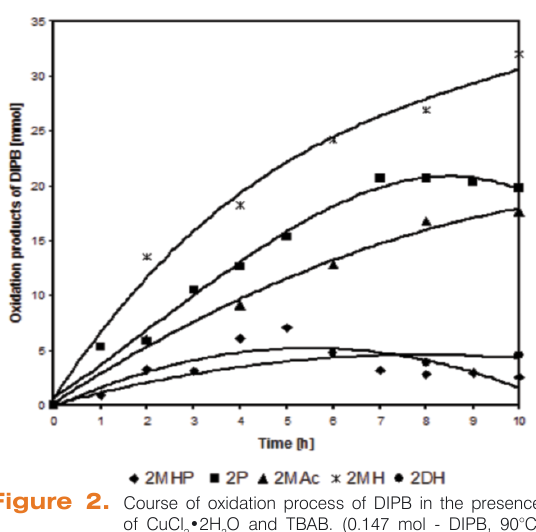
of CuCl •2H O and TBAB. (0.190 mol DIPN, 90°C, 2 2 O - 10 dm 3 h -1 ; 1000 rpm. 2